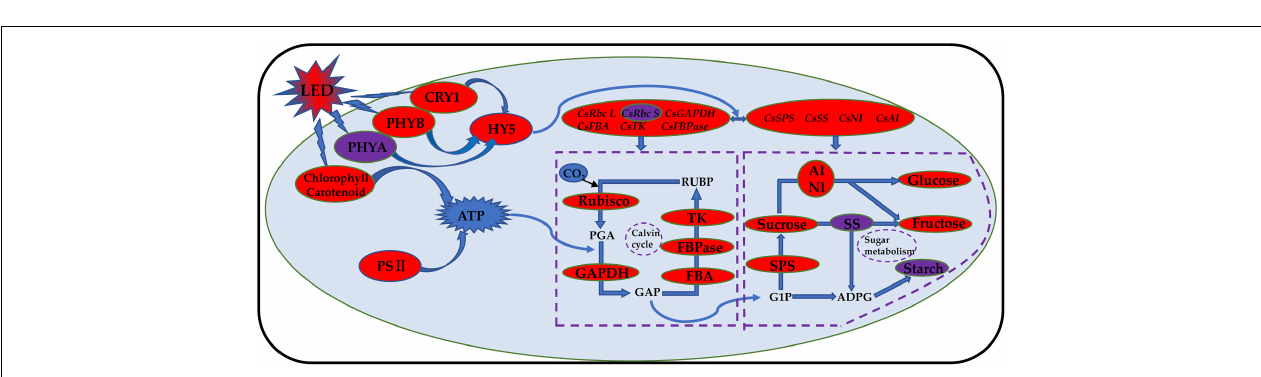
FIGURE 10 | Effects of supplemental LED light duration on the expression levels of CsPHYA (A) , CsPHYB (B) , CsCRY1 (C) , and CsHY5 (D) in cucumber leaves. After LED light treatment for 30 days, 10 cucumber leaves were selected from the third leaf from the top in each treatment, washed and dried immediately, and then placed in liquid nitrogen. They were stored in a refrigerator at –80 ◦ C for total RNA extraction and subsequent qRT-PCR experiments. Values are expressed as mean ± SE ( n = 3). Bars that are significantly different in terms of the Duncan’s multiple range test ( p < 0.05) are indicated with different lowercase letters.